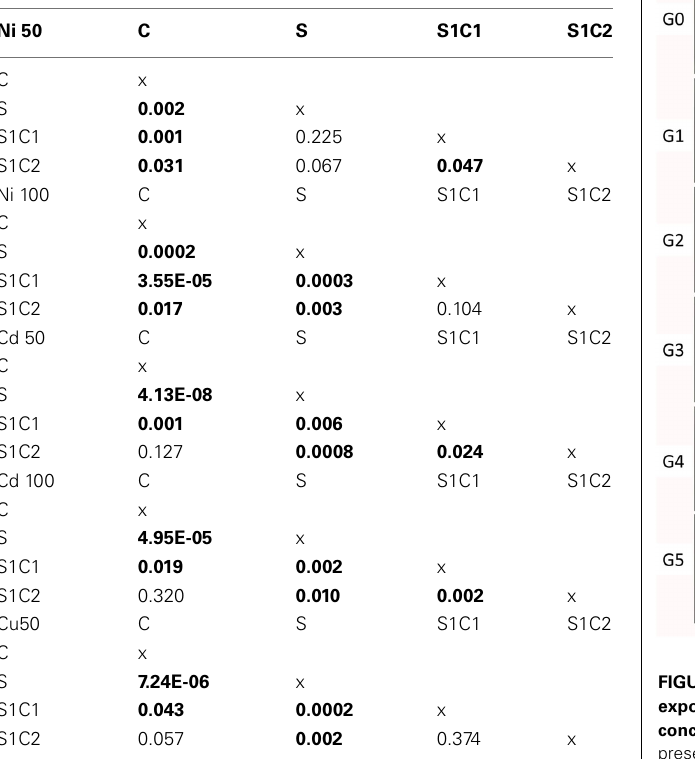
TableA1 | Statistical analysis of HRF using single factorANOVA.